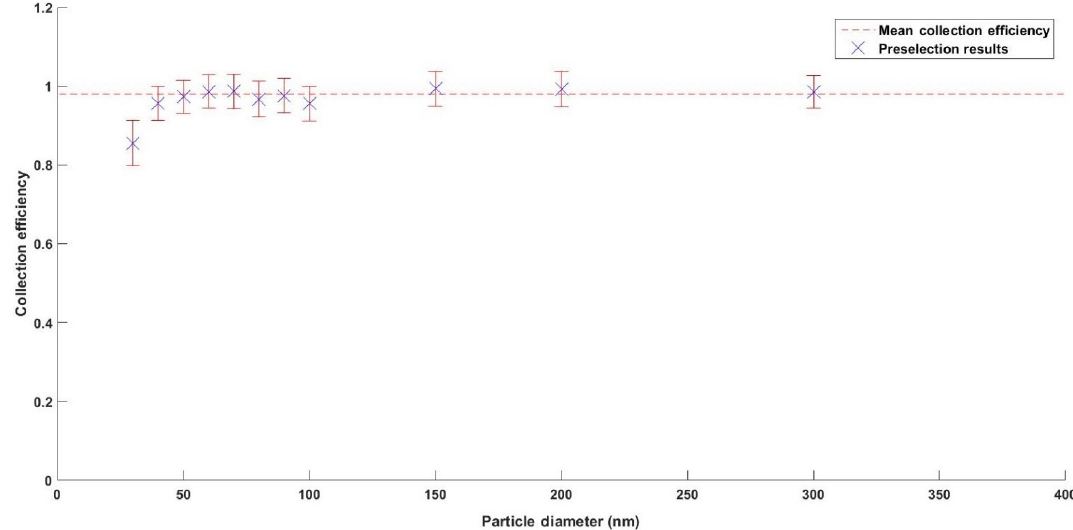
Figure 3. Calculated collection efficiencies for DEHS preselection measurements with standard error bars and mean collection efficiency.